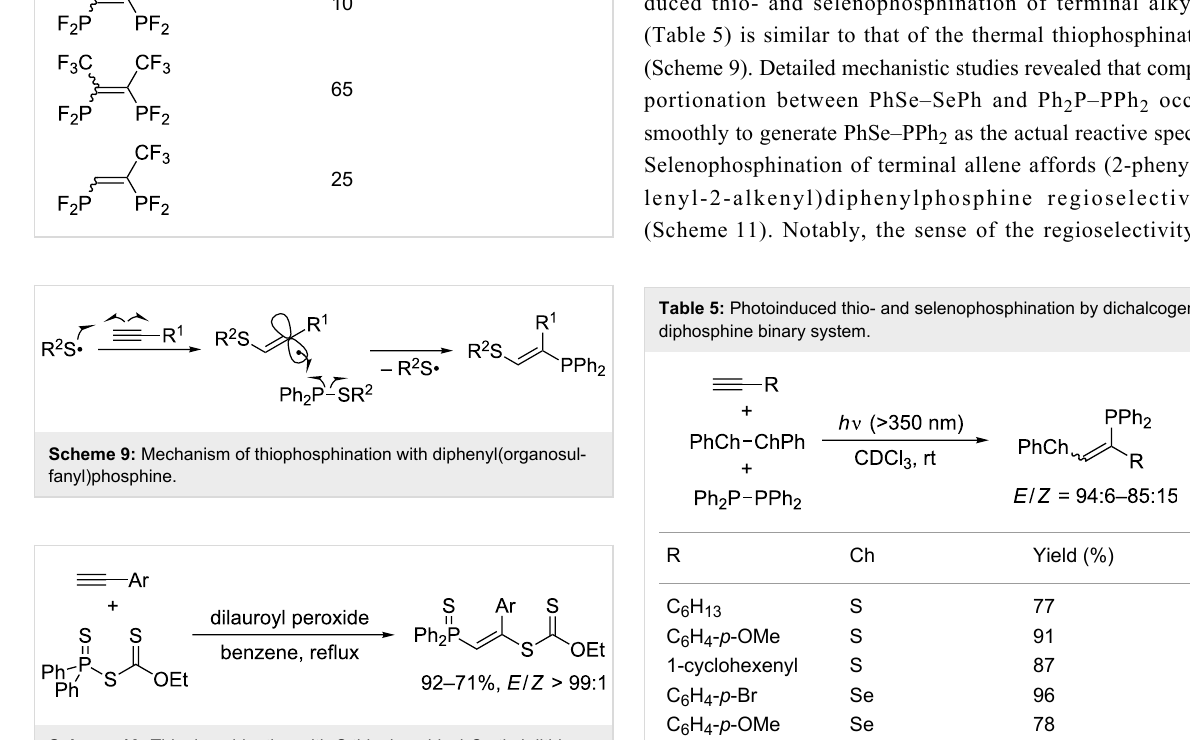
Scheme 10: Thiophosphination with S -thiophosphinyl O -ethyl dithio- carbonate.